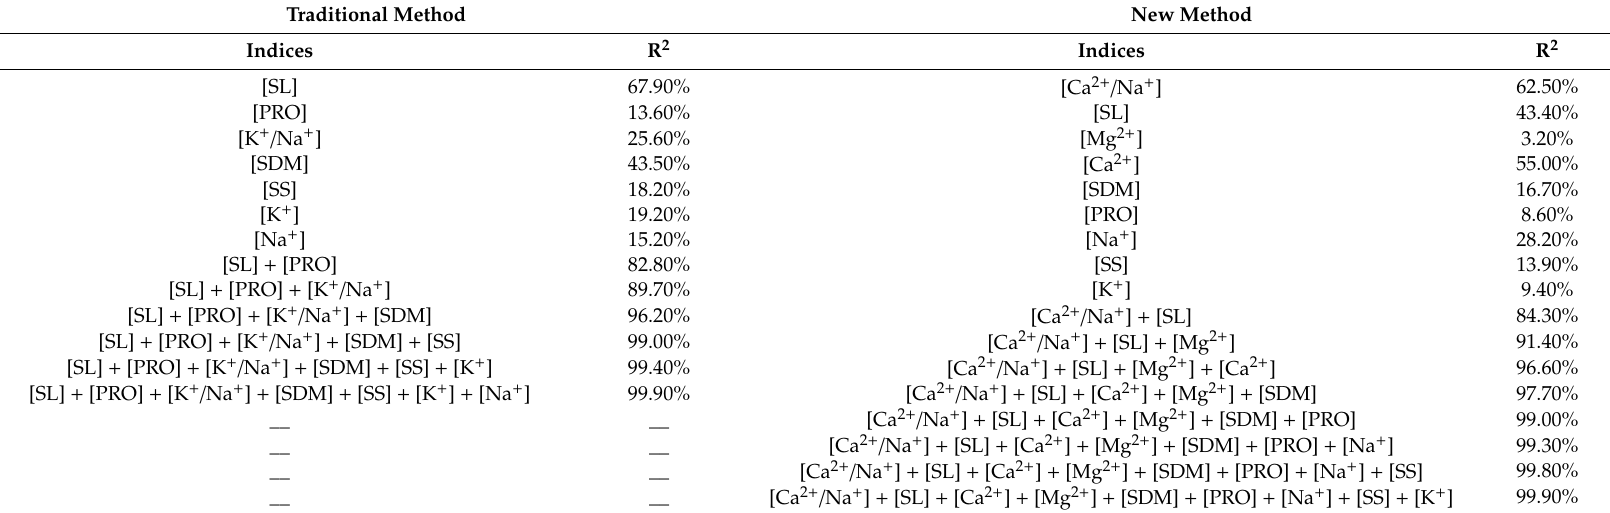
Table 3. Contributions of the saline-alkaline-tolerance coe ffi cients (SATCs) of growth and physiological indices to the D-value based on stepwise regression under two